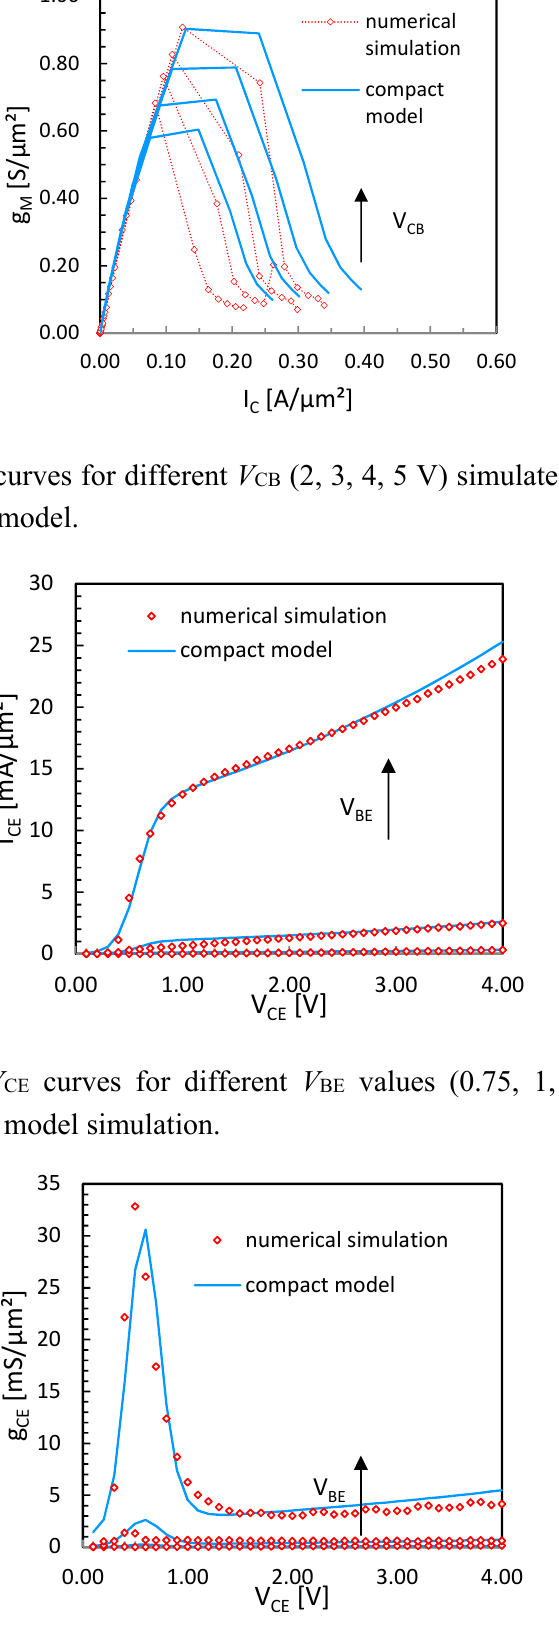
Figure 8. g CE versus V CE curves for different V BE values (0.75, 1, 1.25 V), numerical simulation and compact model